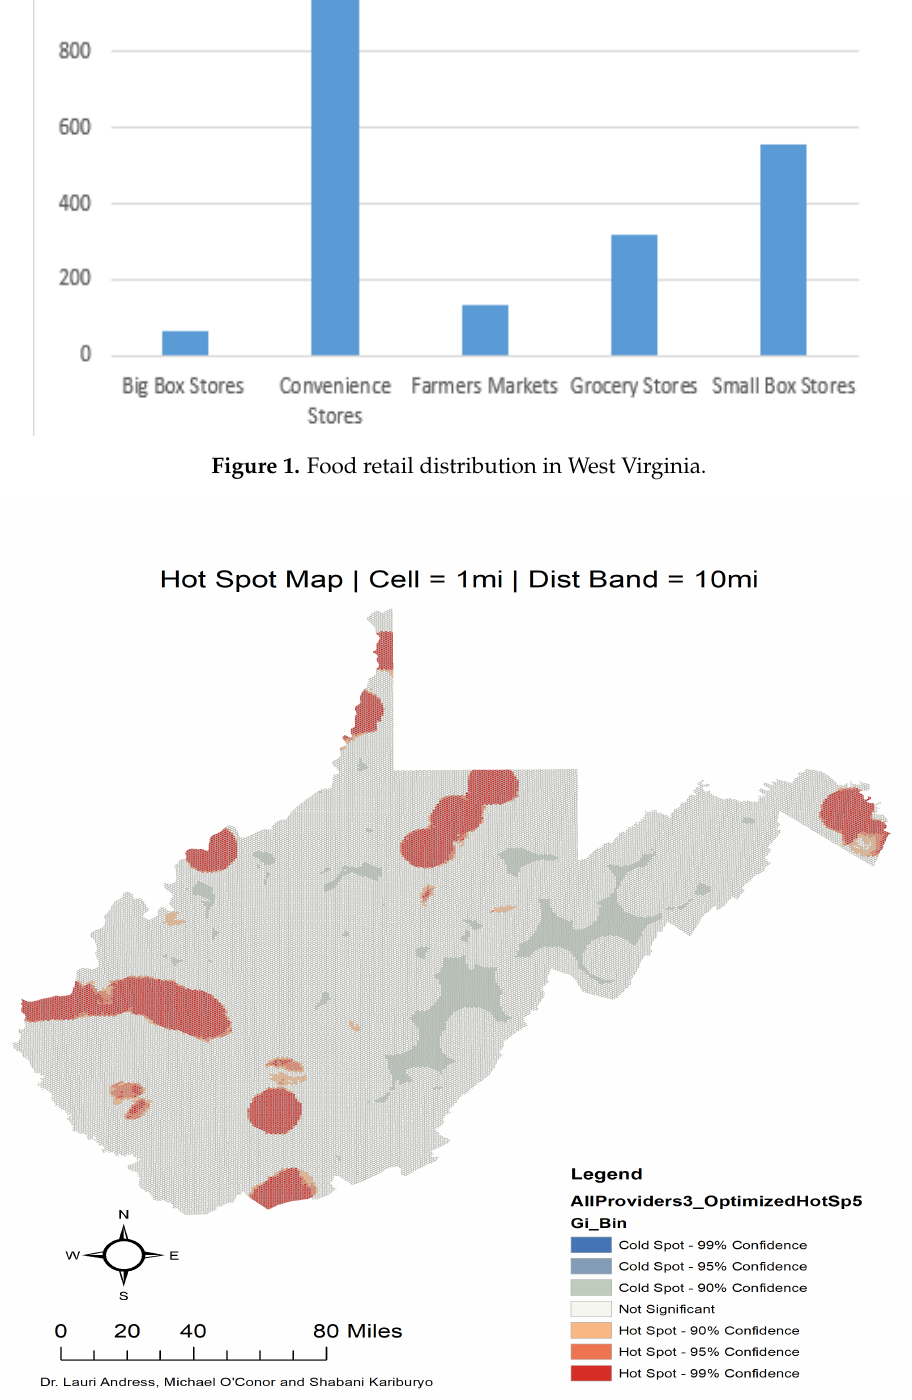
Figure 2. Hot spots and Cold spots of food providers in West